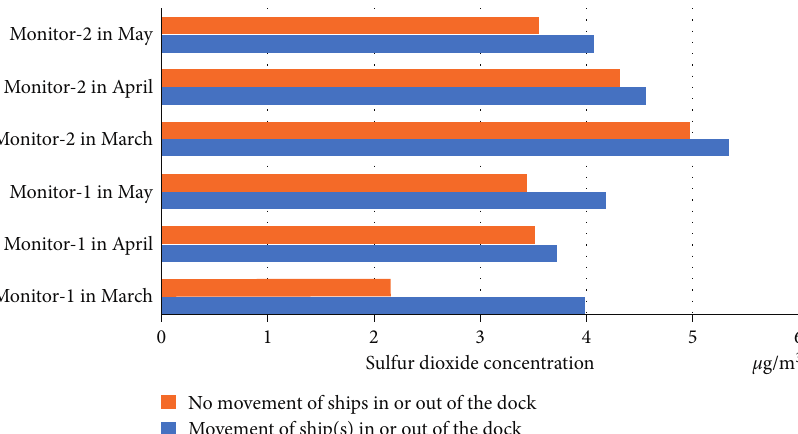
Figure 4: Average SO 2 concentration within one hour of ships’ arrival or departure versus periods of no ship movement in or out of the dock.